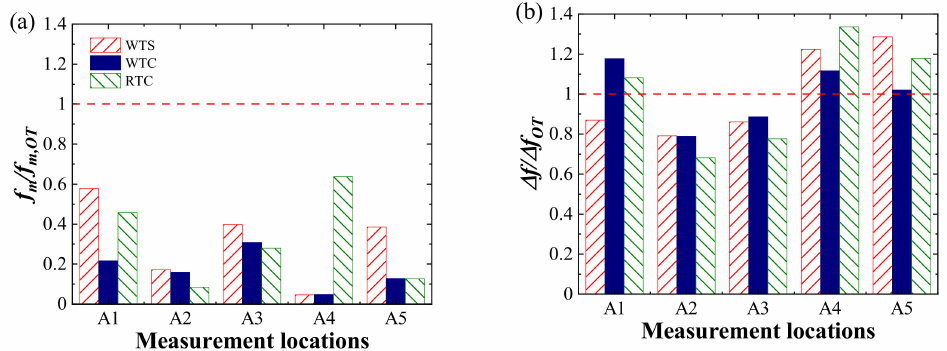
Figure 10. Metrics on spectra shifts at measurement locations: ( a ) median of the normalized frequency; ( b ) the bandwidth of the normalized